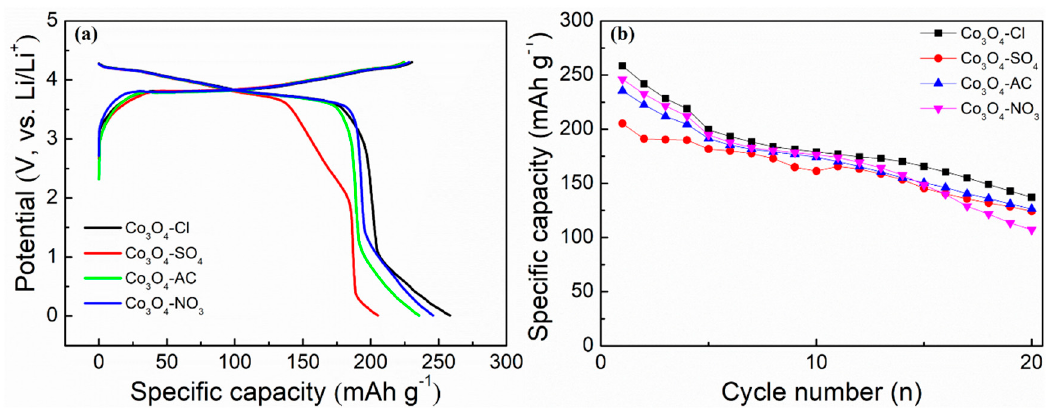
Figure 12. ( a ) The initial charge–discharge profiles of the full batteries at 40 mA·g − 1 , and ( b ) cycle performance of the full batteries using NCM811 cathode materials and the synthesized Co 3 O 4 anode materials at 100 mA·g − 1 .